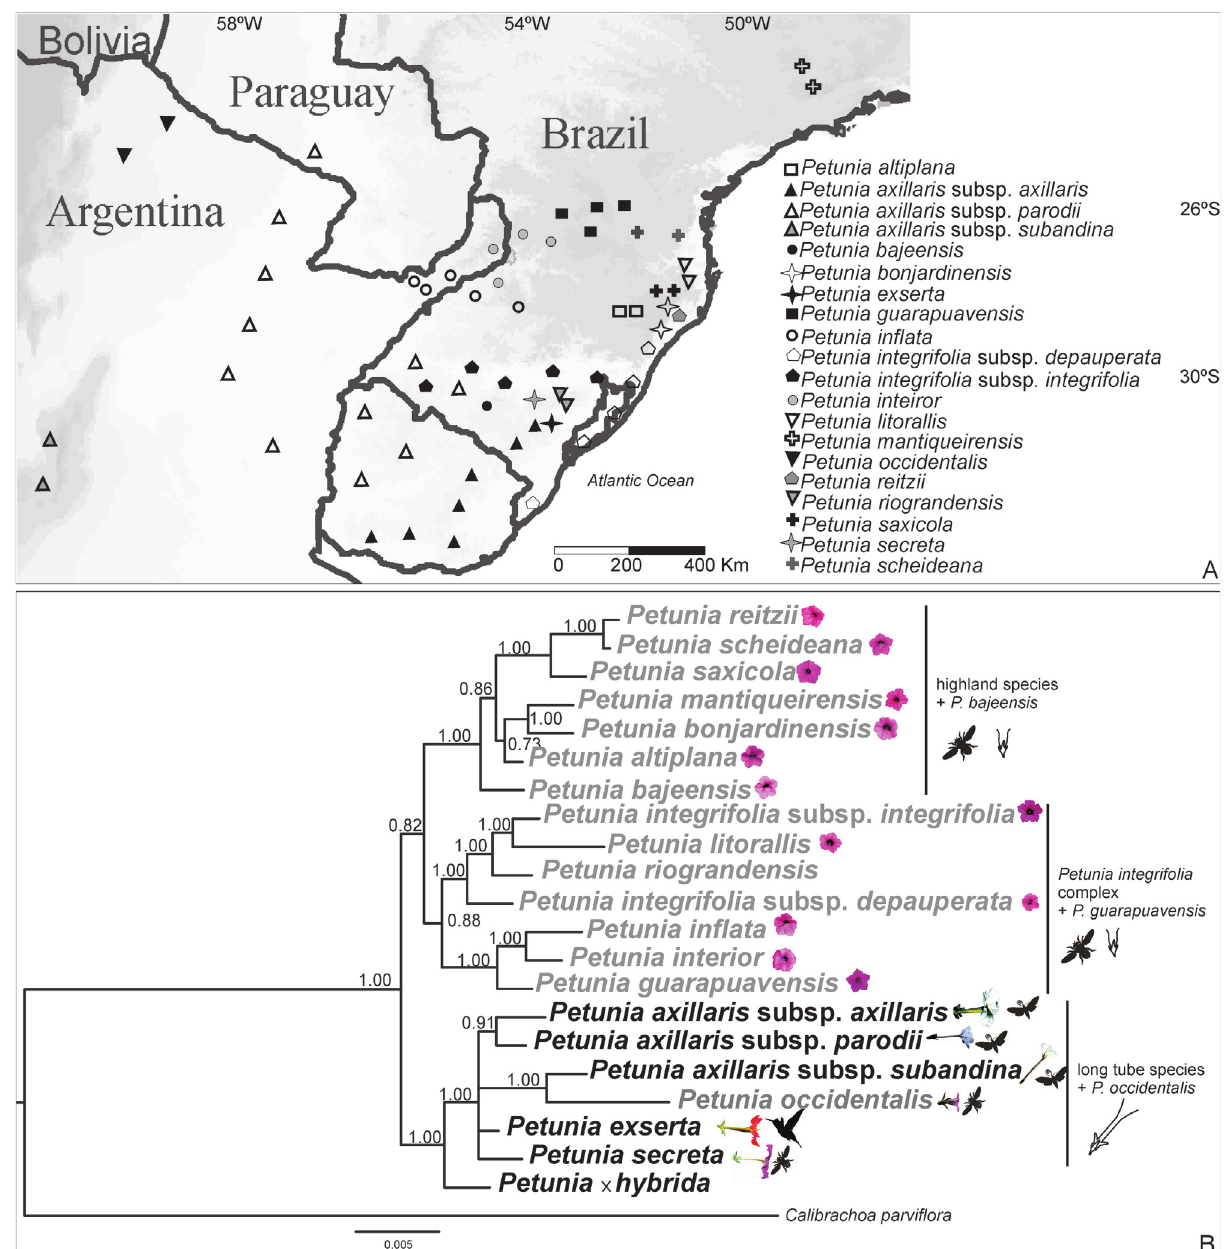
Figure 1 - Bayesian inference phylogeny and geographic distribution of Petunia species. (A) Schematic representation of Petunia geographic distribu- tion. (B) Bayesian phylogenetic tree considering the intron/exon WUSCHEL -related homeobox gene sequences in Petunia species. The posterior proba- bilities are indicated above the branches. The short corolla tube species names are in gray, and the long corolla tube species are in black. Species pollinators are represented (bee, hawk-moth, and